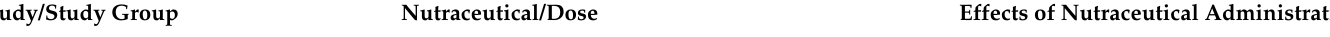
Type of Study/Study